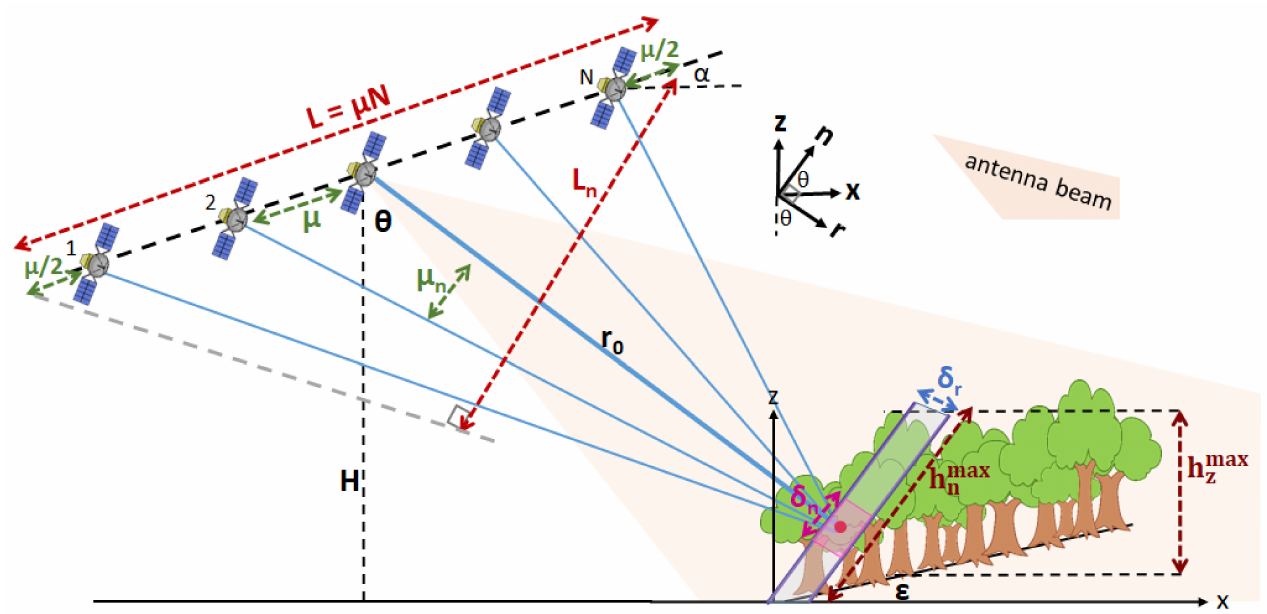
Figure 1. Multi-static observation geometry, relevant parameters, and spatial